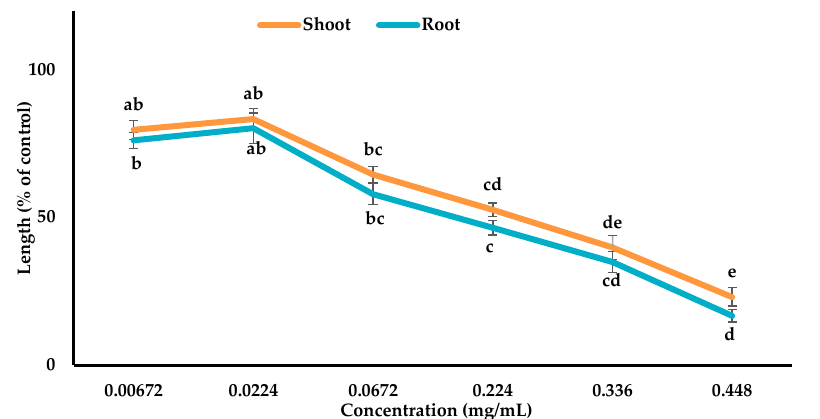
Figure 6. Phytotoxic potentials of compound 2 against the shoot and root growth of Lepidium sativum . The values are the mean ± standard error (SE) from two different studies with 10 seedlings for each treatment. Different letters indicate significant variations according to Tukey’s HSD test at the 0.05 level of significance.